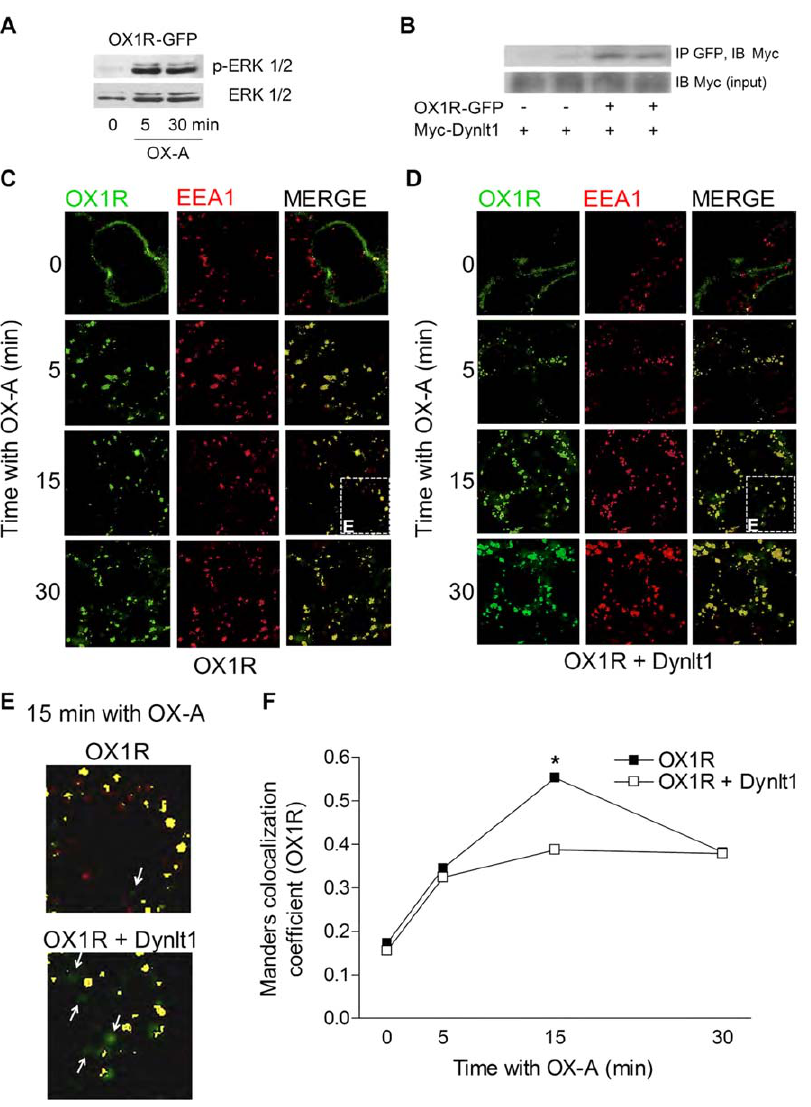
Figure 8. Dynlt1 alters the intracellular localization of OX1R following ligand-induced internalization. ( A ) HEK293 cells were transfected with pEGFP-N1-OX1R and stimulated with OX-A for the indicated times. IB analysis of whole cell lysates shows that ERK1/2 phosphorylation can be achieved after stimulation of this OX1R-GFP fusion protein with OX-A. ( B ) HEK293 cells were transfected with pCS2-Myc-Dynlt1 and pEGFP-N1-OX1R or corresponding empty vector. Whole-cell lysates were subjected to IP with an anti-GFP antibody to immunoprecipitate OX1R-GFP and anti-Myc antibody to reveal Myc-Dynlt1. Equal transfection of Myc-Dynlt1 was verified by IB with anti-Myc antibody on cell extracts (input). ( C, D ) HEK293 cells stably expressing OX1R-GFP were transfected with control plasmid ( C ) or pCS2-FLAG-Dynlt1 ( D ), stimulated with OX-A for 5–30 min or left un- stimulated (0 min) and analyzed by fluorescent microscopy. Cells were labeled with an antibody specific for a marker of early endosomes, EEA1. Maximum co-localization of green pixels with red pixels occurs after 15 min OX-A in control conditions. However, when over-expressing Dynlt1, co- localization is rather similar across OX-A stimulation times. Left panels: green GFP fluorescence; OX1R, middle panels: EEA1 labeling, red ALEXA 568 secondary antibody; early endosomes, and right panels: the merged images. ( E ) Magnification of merged fields from panels C and D (white squares) after 15 min OX-A without or with Dynlt1 over-expression. White arrows indicate OX1R-GFP signal (green) not co-localized with endosome marker (red). ( F ) Manders’ co-localization coefficient for green channel (OX1R-GFP) was generated on images that were co-localized using Openlab software. Manders’ co-localization coefficient (OX1R): co-localized green and red pixels divided by total number of green pixels over threshold. Results represent the mean 6 SEM of triplicates from one experiment, where at least 5 fields with 1–3 cells in each were analyzed for each time point. This experiment was done twice with similar results (three times for the 0 and 15 min time points). The co-localization of OX1R-GFP with the EEA1 marker for endosomes, after 15 min OX-A, is decreased upon Dynlt1 over-expression. *: p , 0.05 when compared to control transfection (without Dynlt1) after 15 min OX-A.